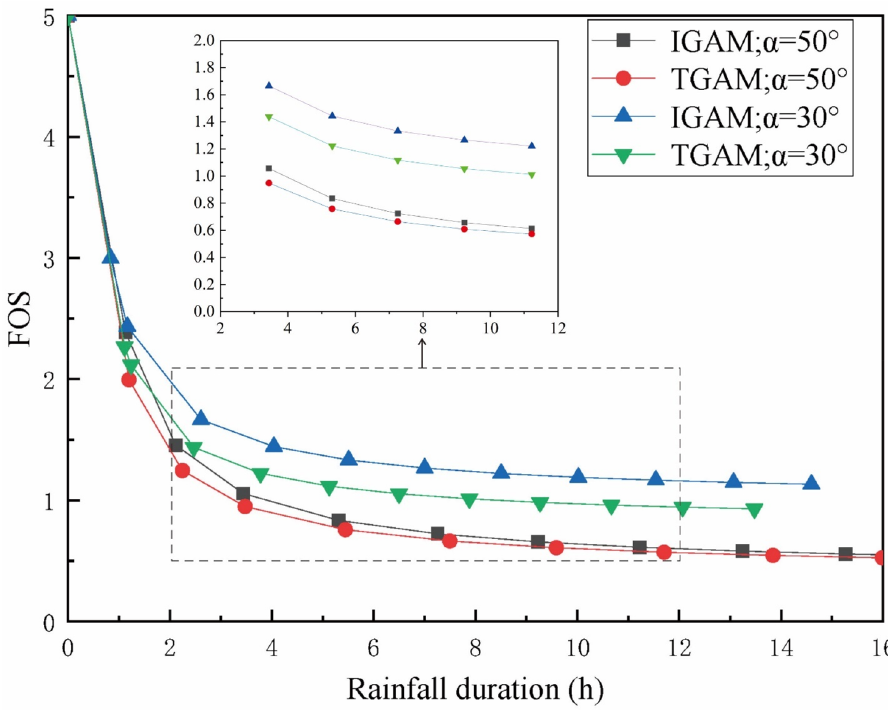
Figure 11. Variation of FOS with rainfall time at different